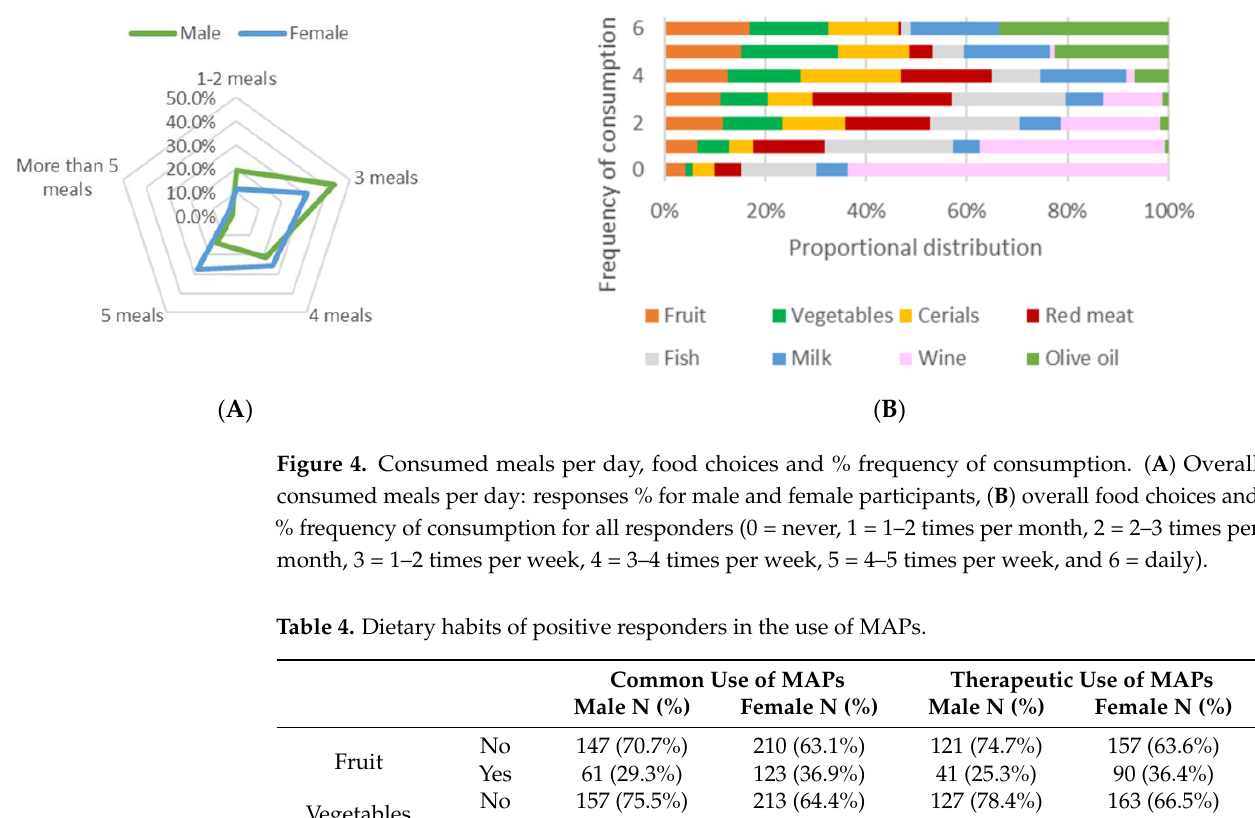
Table 4. Dietary habits of positive responders in the use of MAPs. Common Use of MAPs Therapeutic Use of MAPs